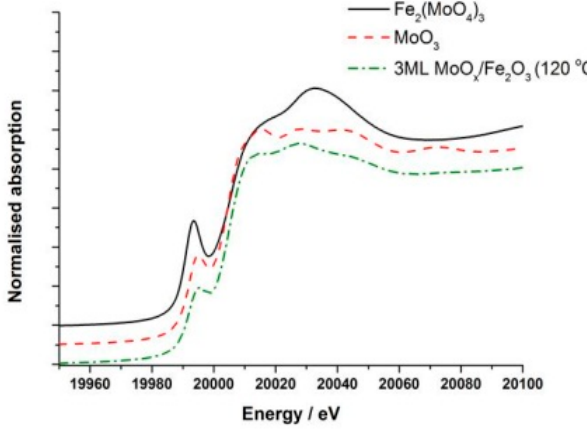
Figure 4. Normalised XANES spectra of dried 3ML MoO x /Fe2O3 (120 °C), MoO 3 , and Fe 2 (MoO 4 ) 3 ; Image adapted from C. Brookes et al. ACS Catal. , 2014 , 4 (1), pp. 243–250 [16].